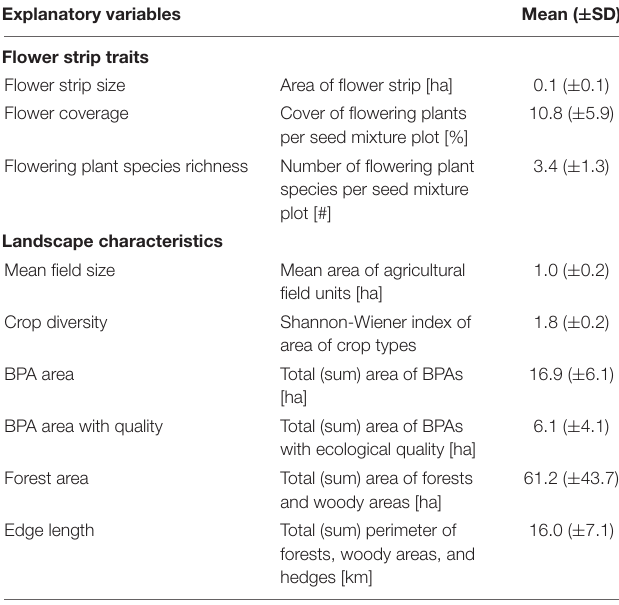
TABLE 1 | Description of flower strip traits and landscape characteristics used as explanatory variables in all models with means ± standard deviations per flower strip and 1 km-radius landscape circles, respectively.